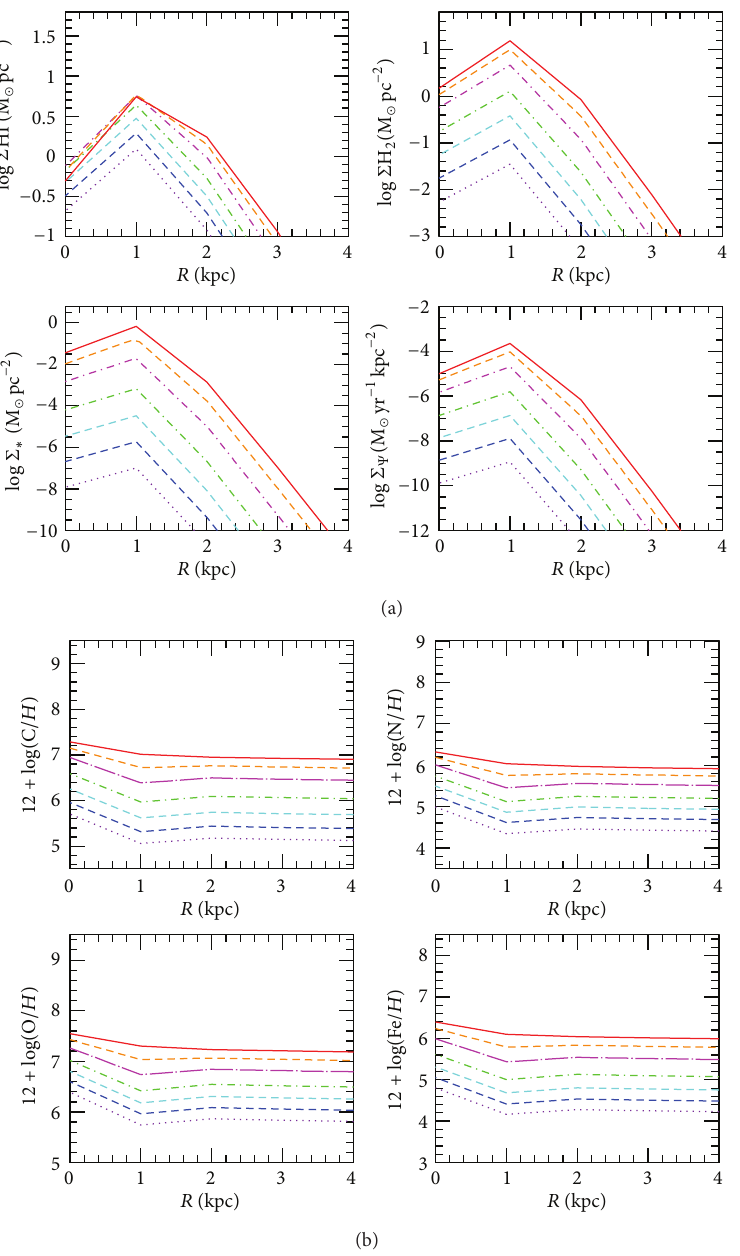
Figure 8: (a) Radial distributions of the surface density of diffuse gas, Σ , molecular gas, Σ , and stellar mass, Σ ∗ , in M ⊙ pc −2 , and the HI H 2 star formation rate surface density, Σ , in M ⊙ yr −1 pc −2 , all in logarithmic scale, for the least massive galaxy of our example table, with SFR = 48 kms −1 . (b) Evolution with redshift of radial distributions of elemental abundances, C, N, O, and Fe of the same 𝑉 max